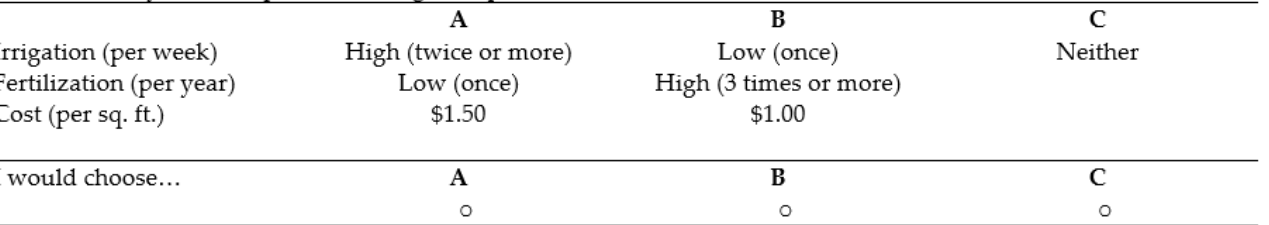
6 of 16 Table 1. Attributes and Attribute Levels for the Choice Experiment. Turfgrass Attribute Attribute Levels Irrigation Requirement Low (once per week) High (twice or more per week)